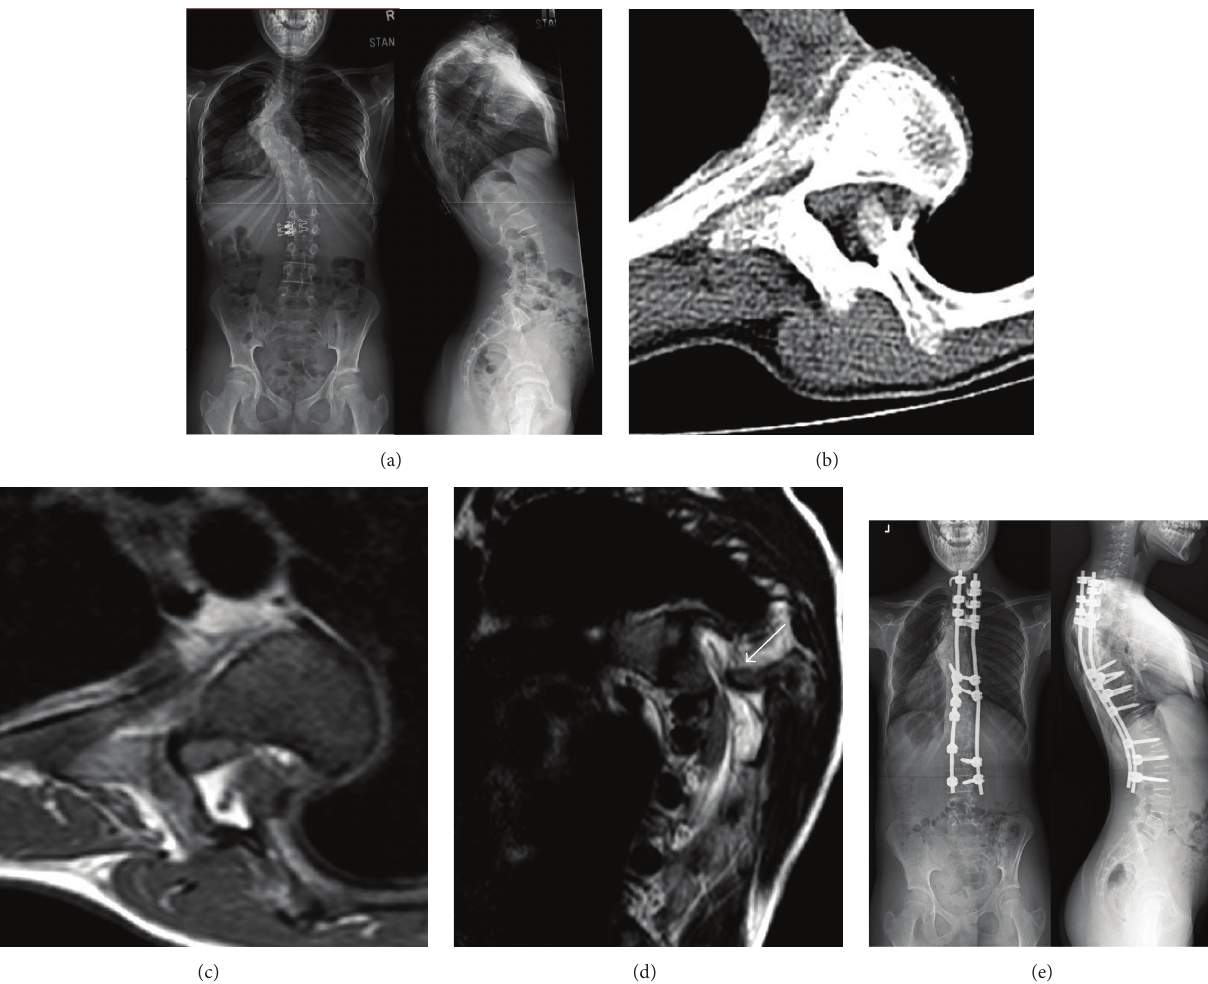
Figure 1: Preoperative whole spine AP and lateral X-ray (a). Preoperative CT (b) and axial T2 MRI (c) demonstrating the right 6th rib head intracanal dislocation and cord impingement. (d) Preoperative sagittal T2 MRI views demonstrating the rib head cord impingement and the flattening adjacent to the acute kyphosis (white arrow). Whole spine AP and lateral (e) X-rays 2 years